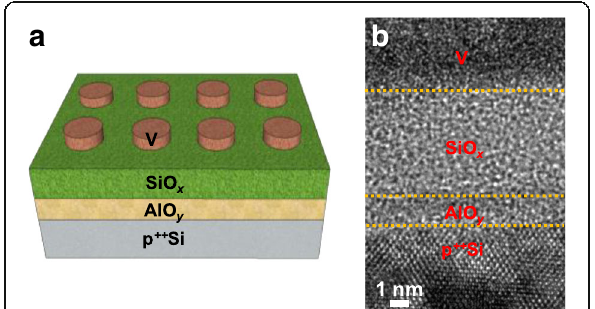
Fig. 1 Device configuration of V/SiO x /AlO y /p ++ Si. a Schematic drawing and b TEM